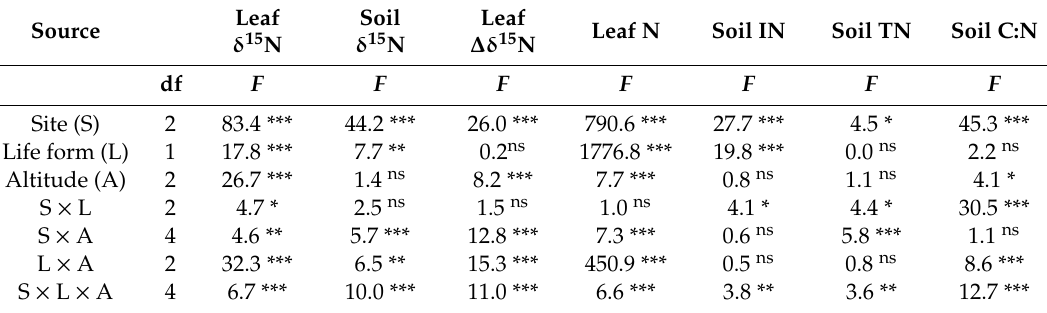
Table 2. Three-way ANONAs of the e ff ects of climate zones (site), altitude, life form and